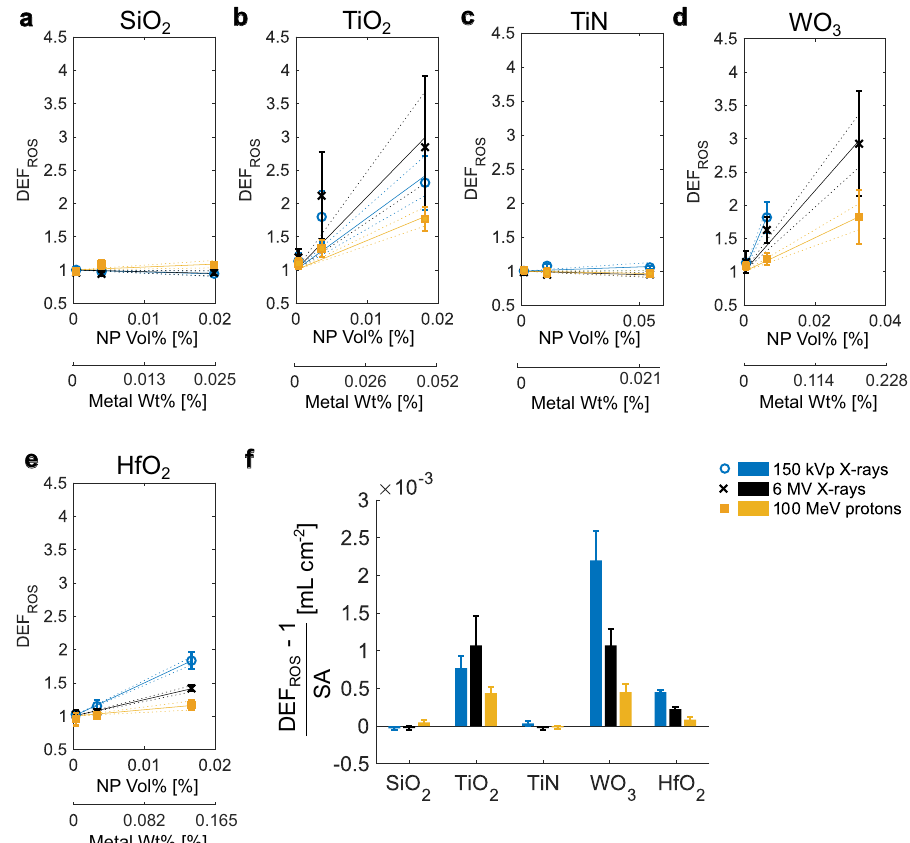
Fig. 4 Reactive oxygen species (ROS) generation in nanoparticle suspensions. Chemical dose-enhancement factors (DEF ROS ) for SiO 2 ( a ), TiO 2 ( b ), TiN ( c ), WO 3 ( d ), and HfO 2 ( e ) as assessed using the acellular H 2 DCF-DA assay under 150 kVp and 6 MV photon, as well as 100 MeV proton irradiation. The exposed nanoparticle surface areas were kept constant (36.8, 368, and 1840 cm 2 /mL), thereby giving different volume or metal mass concentrations ( x -axes) for each nanoparticle. Data in a – e expressed as mean ± SD for n = 6 samples examined over 2 independent DCF experiments. Straight and dotted lines show slope and 95% con fi dence level prediction bounds of linear fi t, respectively. Bars and error bars in f represent the slopes and 95% con fi dence interval from the linear regression response for DEF ROS per surface area concentration of each nanoparticle and for each irradiation condition ( n = 18 sample points per regression),